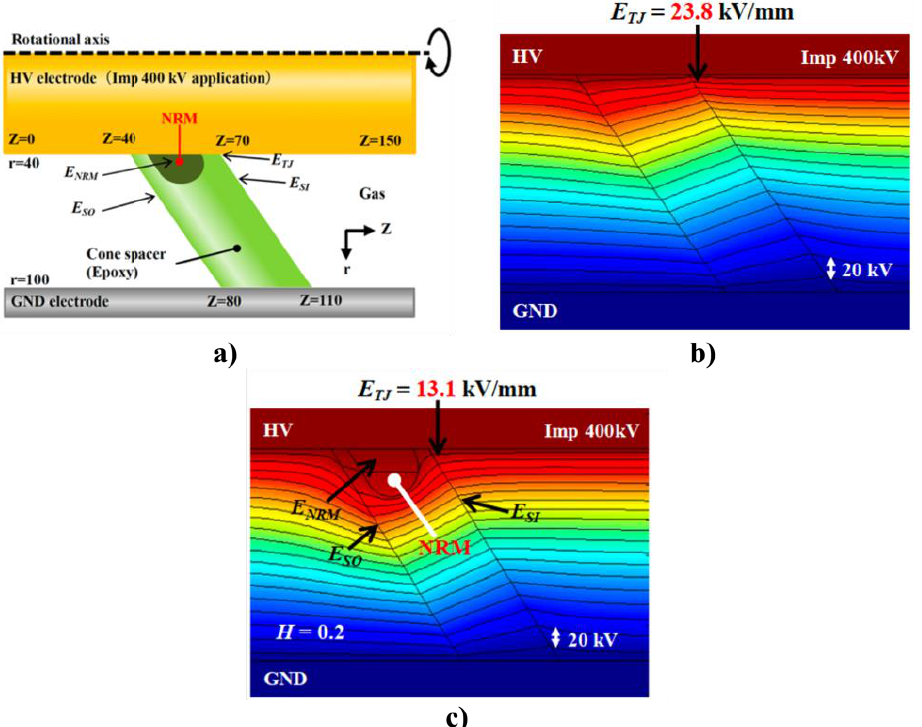
Figure 55. Gas-insulated switchgears using nonlinear resistive materials: ( a ) model, ( b ) distribution of electric field without and ( c ) with nonlinear resistive material ( E = 1000 V/mm). © 2021 IEEE. Reprinted, with permission, from [47].